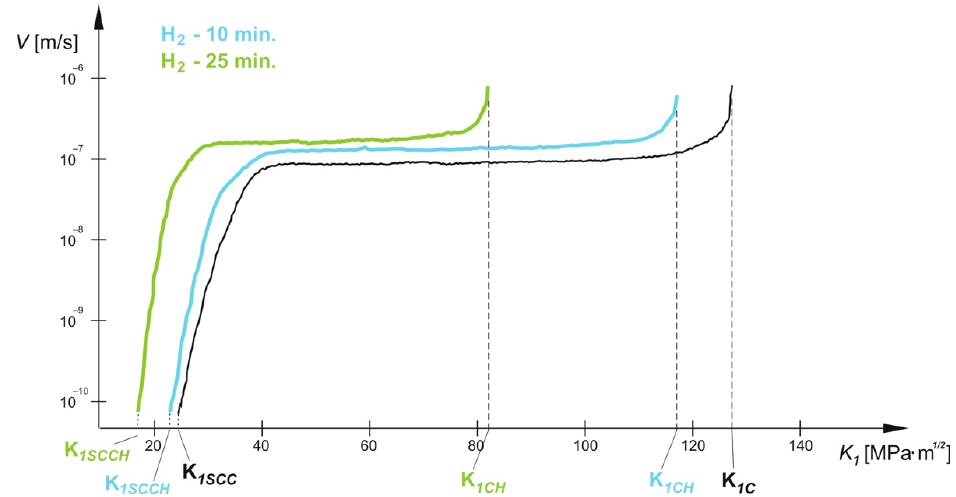
Figure 7. The dependence of the crack propagation rate on the value of the stress intensity factor K 1 for not-hydrogenated and hydrogenated (H 2 ) 6060 alloy—time of the hydrogenation: 10 and 25 min. K 1SCC —nucleation and growth of a stress corrosion crack; K 1SCCH —nucleation and growth of a stress corrosion crack after hydrogenation; K 1C —material separation; and K 1CH —material separation after hydrogenation.